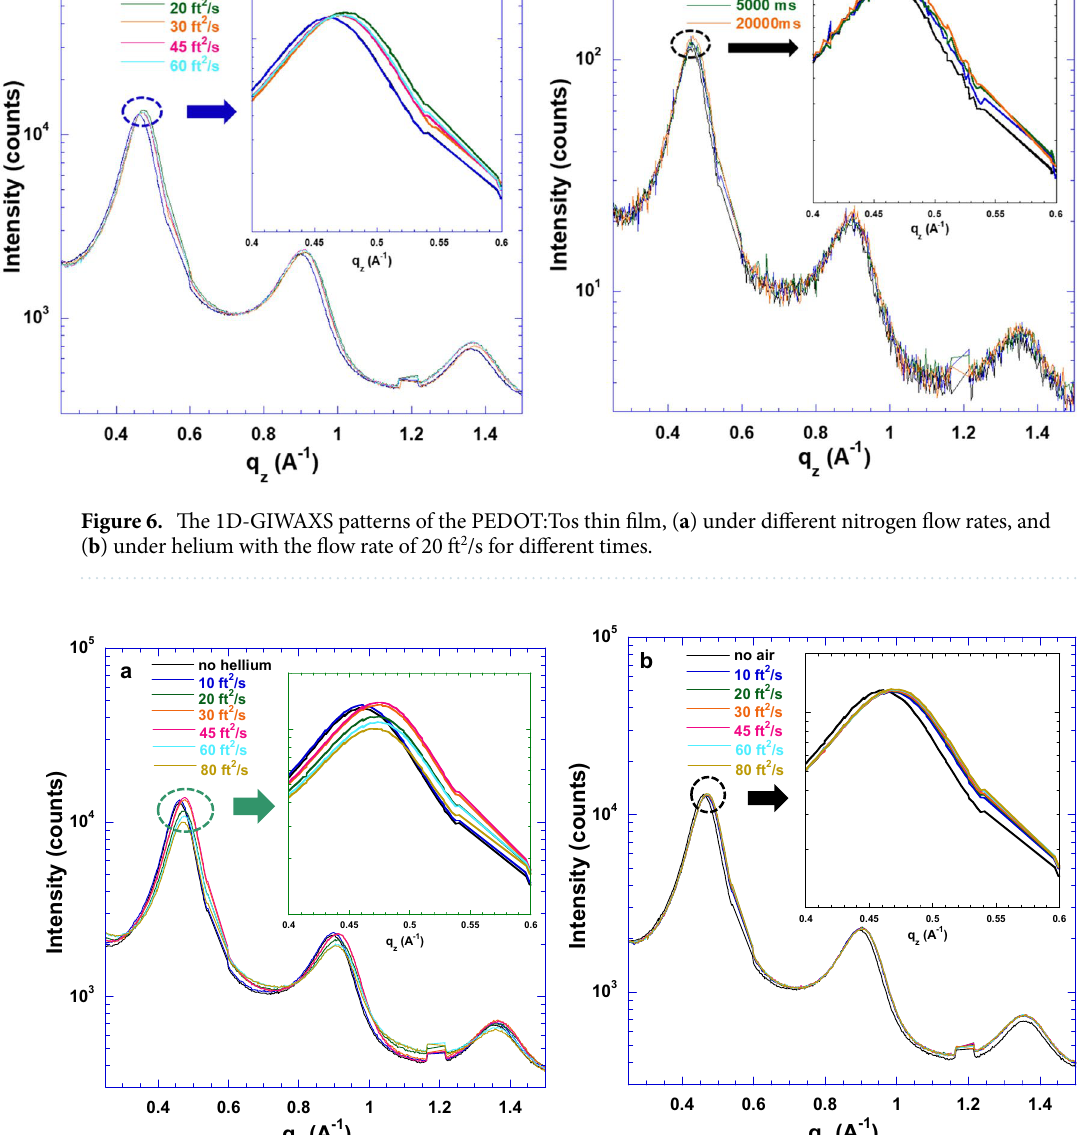
Figure 7. The 1D-GIWAXS patterns of the PEDOT:Tos thin film with the doping level of 43.6% under ( a ) helium, ( b ) compressed air flow pressure with various flow